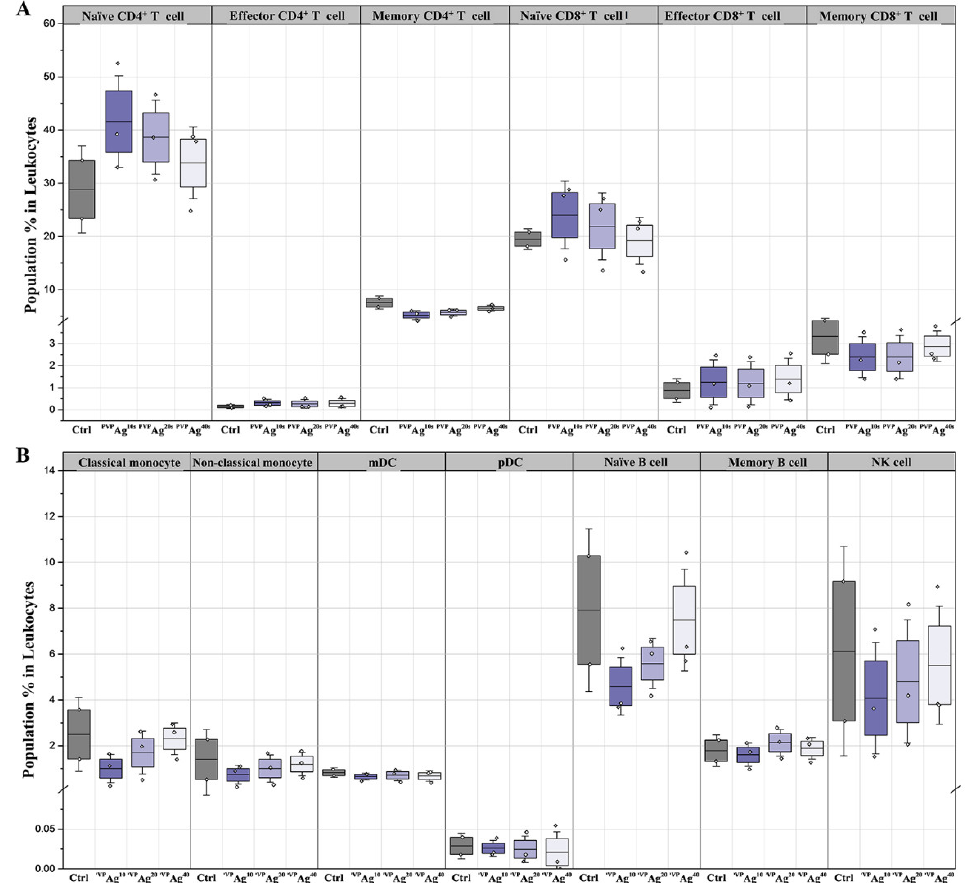
Figure 4. Comparison of the population of ( A ) T cells and ( B ) non-T cells in samples exposed to PVP Ag 10 , PVP Ag 20 , and PVP Ag 40 Ag NPs. PVP Ag 10 , PVP Ag 20 , and PVP Ag 40 Ag